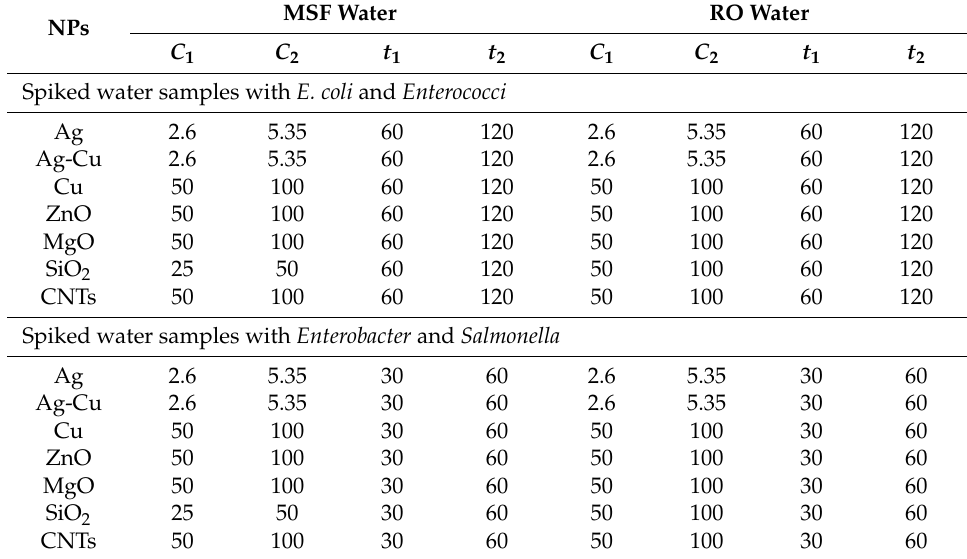
Table 4. Concentrations ( C in µ g/L) of NPs and contact times ( t in min) used with the MSF and RO water samples.